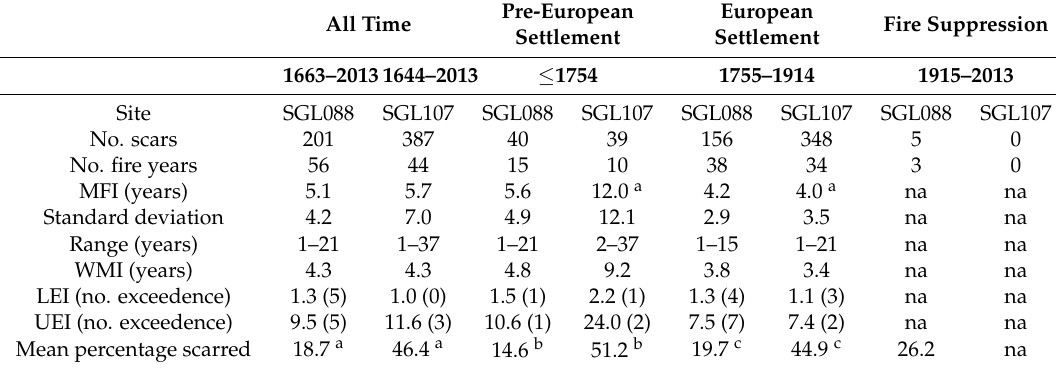
Table 1. Fire-scar history data for SGL 088 and SGL 107 (Ridge and Valley Province, central Pennsylvania,